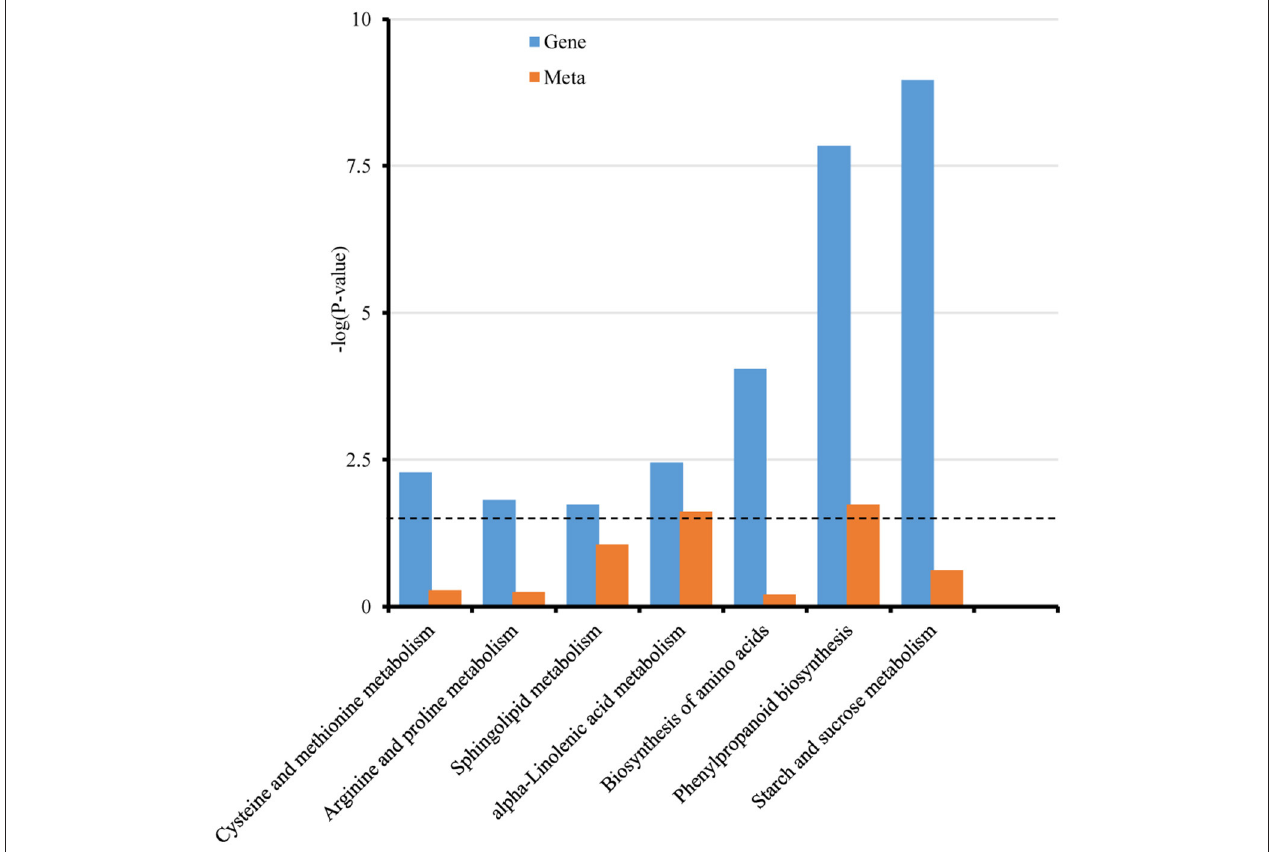
FIGURE 3 | Integrated analyses of transcriptomic and metabonomic results of Rp1-D21 mutant (mt) compared to the wild type (WT). The Kyoto Encyclopedia of Genes and Genomes (KEGG) enrichment histogram of conjoint analysis of DEGs and differential accumulated metabolites (DAMs). The x-axis represents the metabolic pathways and the y-axis represents the expression as -log ( p -value). The blue columns represent the enrichment p -values of DEGs, and the orange columns represent the enrichment p -values of DAMs. The black dotted line represents the threshold for significant enrichment at p < 0.05.